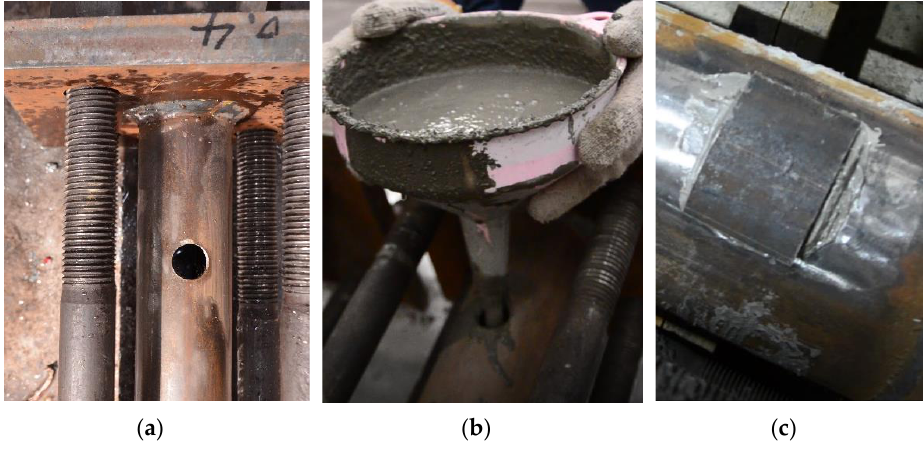
Figure 5. RPC grouting. ( a ) Trepanning; ( b ) Grouting; ( c ) Strengthening.